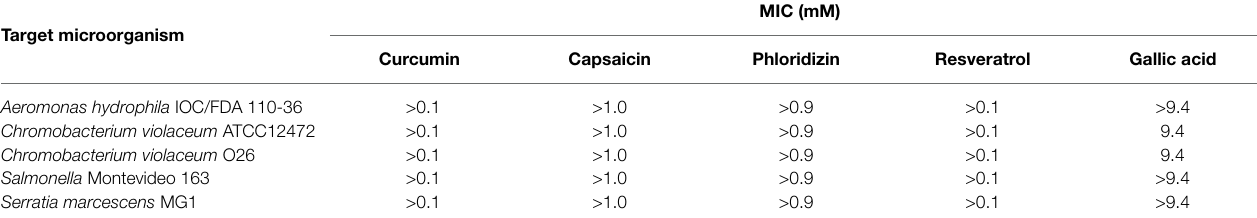
TABLE 1 | Minimum inhibitory concentration (MIC) of phenolic